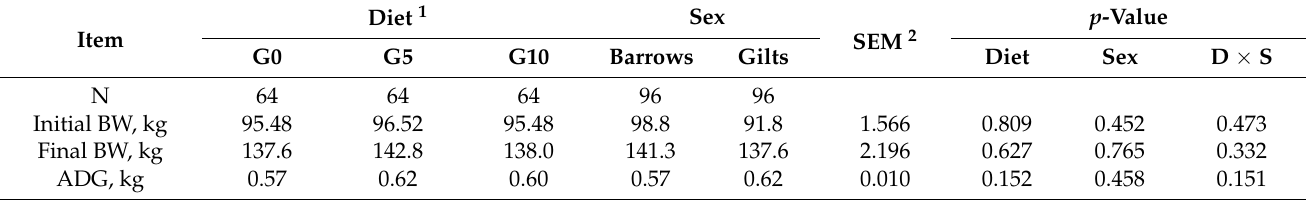
Table 2. Effects of sex and glycerin addition to feed on body weight and average daily gain of Iberian crossbreed pigs. Item